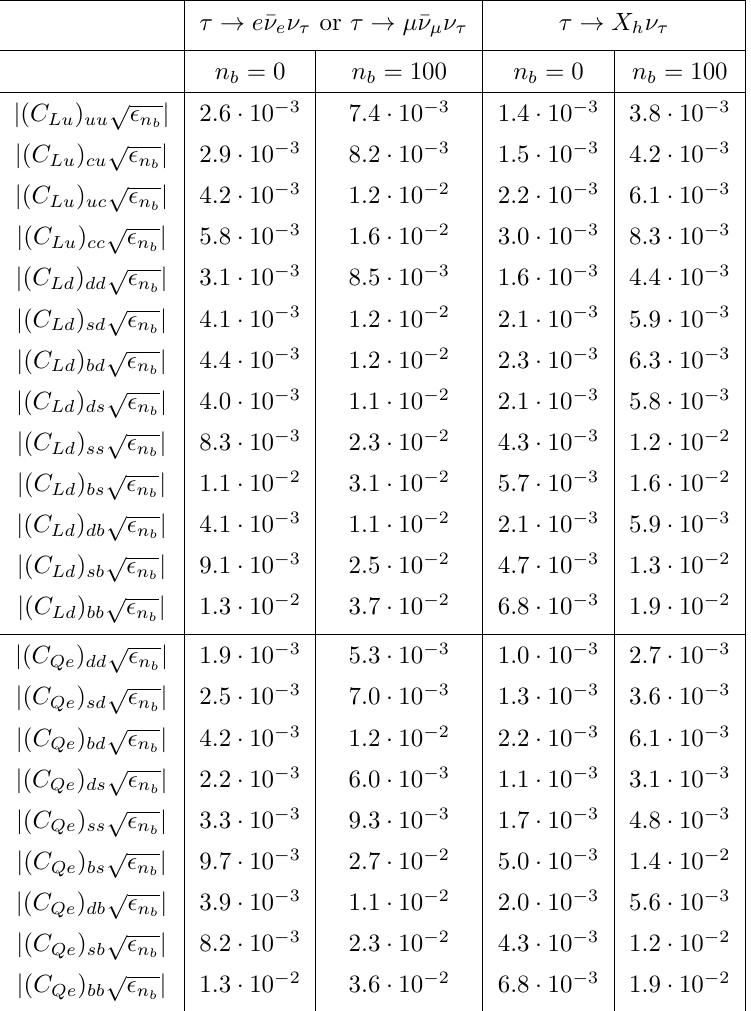
Table 4 . EIC sensitivity to CLFV four-fermion operators with left(right)-handed leptons and right(left)-handed quarks, from the τ electronic, muonic and hadronic decay channels. The two sets of 90% CL bounds are obtained assuming that the EIC will observe n = n events. (cid:15) and (cid:15) accounts for the selection cuts that ensure 0 and 100 background events, 0 100 respectively, and are functions of the decay channel and of the operator